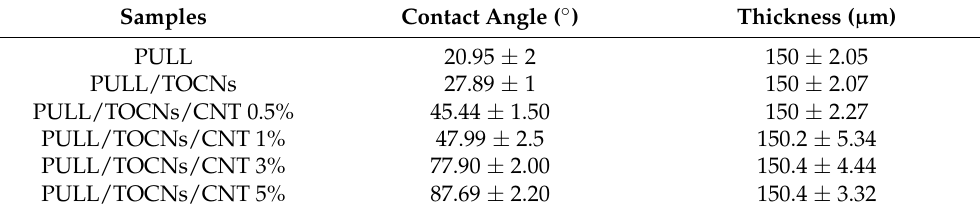
Table 1. Contact angle and thickness of the PULL/TOCNs/CNT nanocomposite